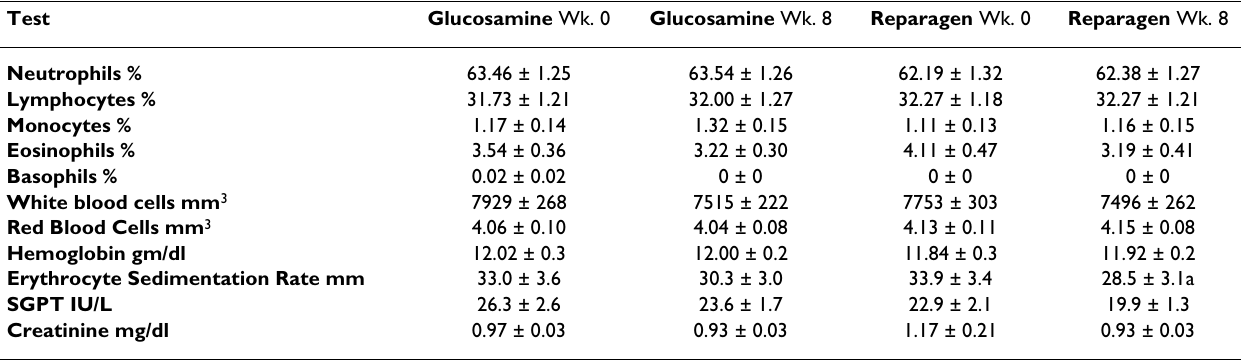
Table 2: Laboratory-based evaluations of safety